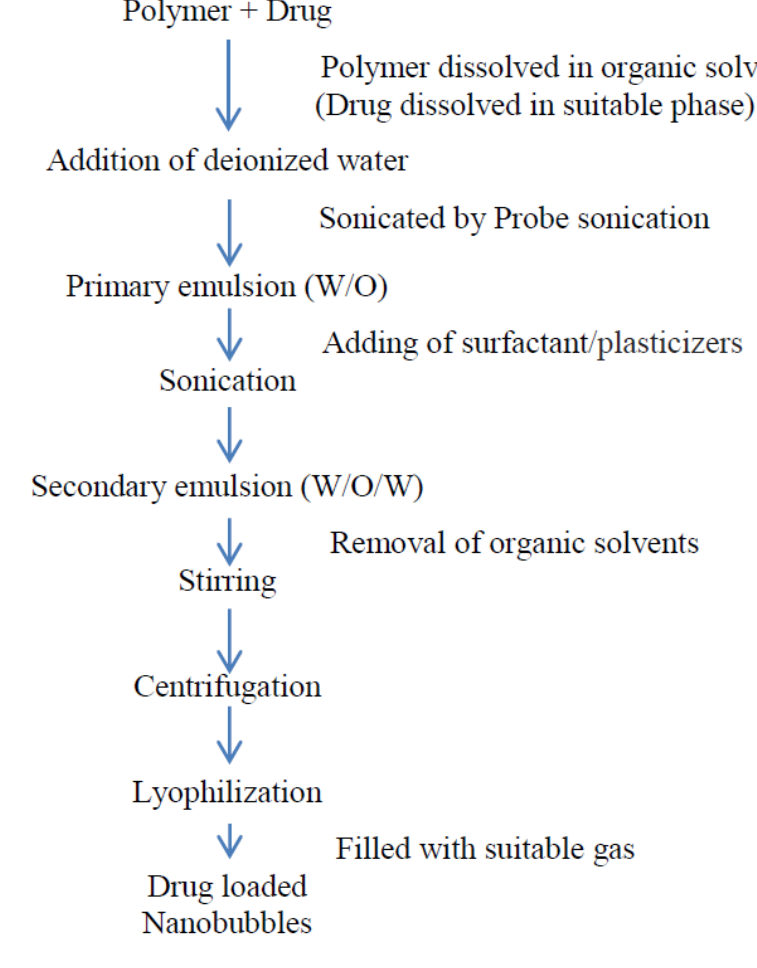
FIGURE 4 - Probe-Type Sonication